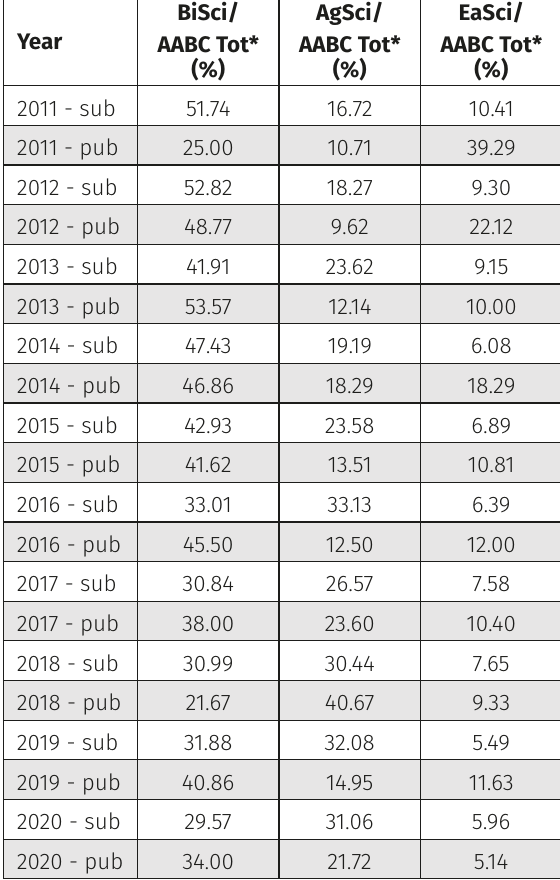
Table II. Proportions of submitted and